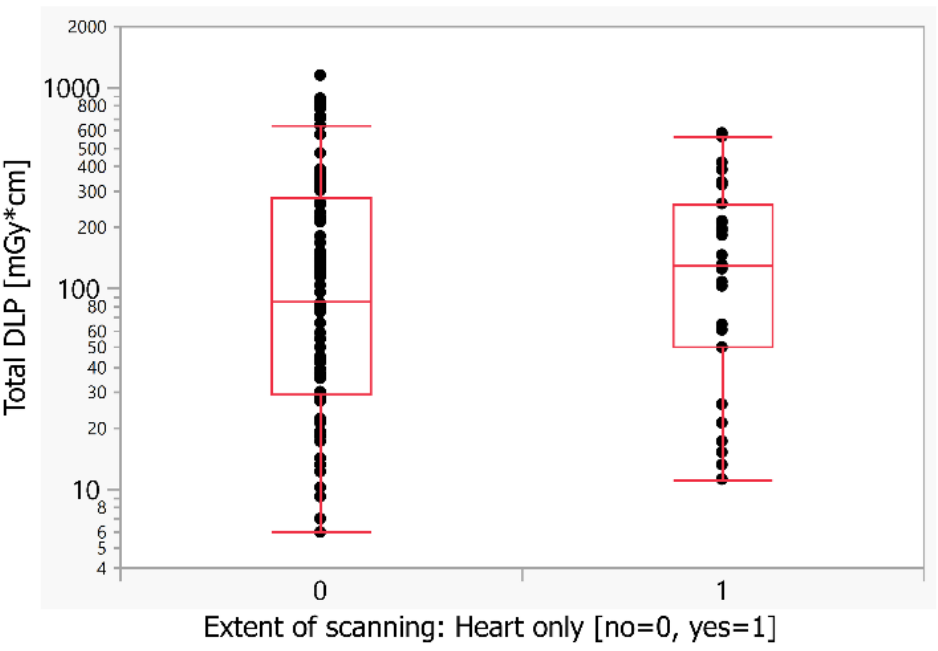
Figure 1. Comparison of the radiation dose for the extent of scanning in the z -axis. DLP—dose length product (mGy*cm).